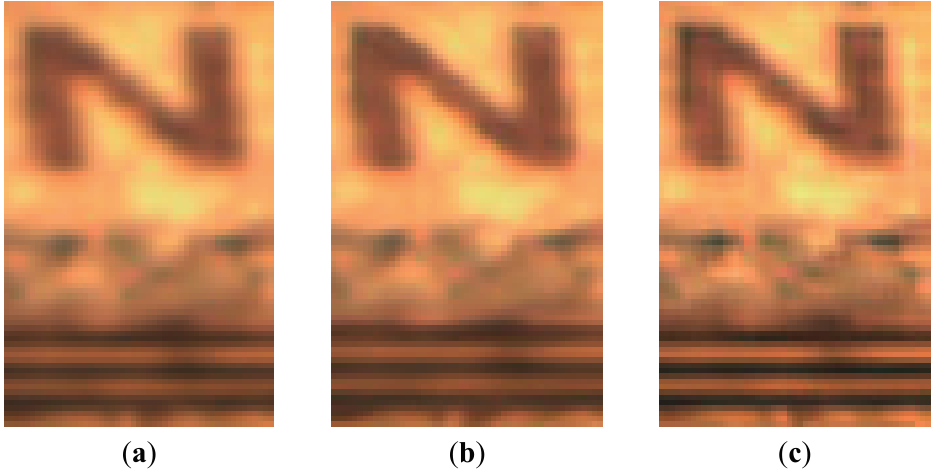
Figure 10. The cropped portions of the Figure 7b–d (color composite of R: 52, G: 32, B: 13). ( a ) bicubic interpolation method; ( b ) SR-SR method; ( c ) the proposed